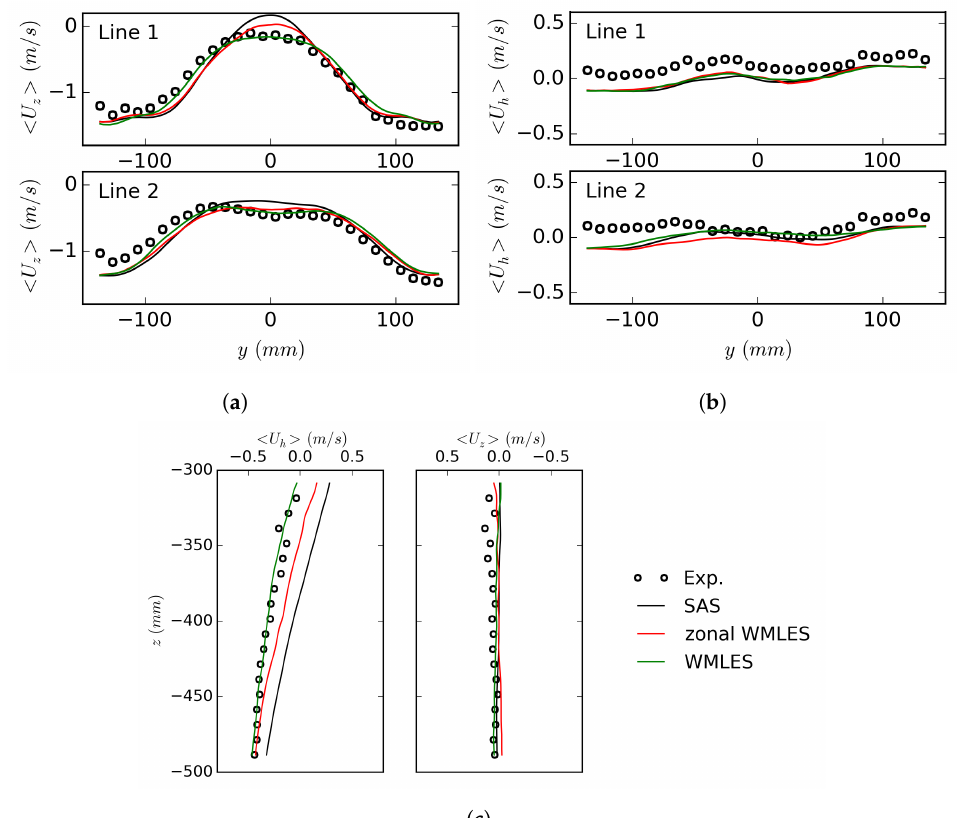
Figure 3. Comparison between the averaged velocities along the measurement lines in Figure 2a in the experiment [44] and the simulations. ( a ) Axial velocity, Lines 1 (upper) and 2 (lower). ( b ) Horizontal velocity, Lines 1 (upper) and 2 (lower). ( c ) Axial (right) and horizontal (left) velocities, Line